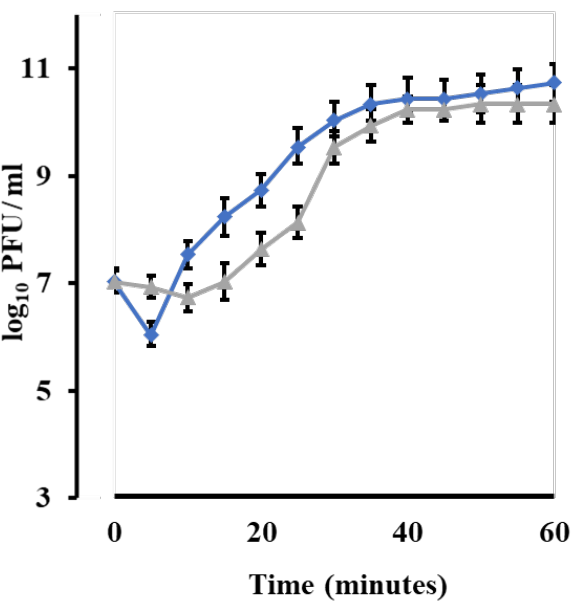
Figure 4. Single step growth curve. The grey line represents nascent phage without chloroform addi- tion (PFU/mL), while the blue line represents phages released after chloroform addition (PFU/mL). The phage titers are recorded as means and the error bars are ± standard deviation of three replicates.